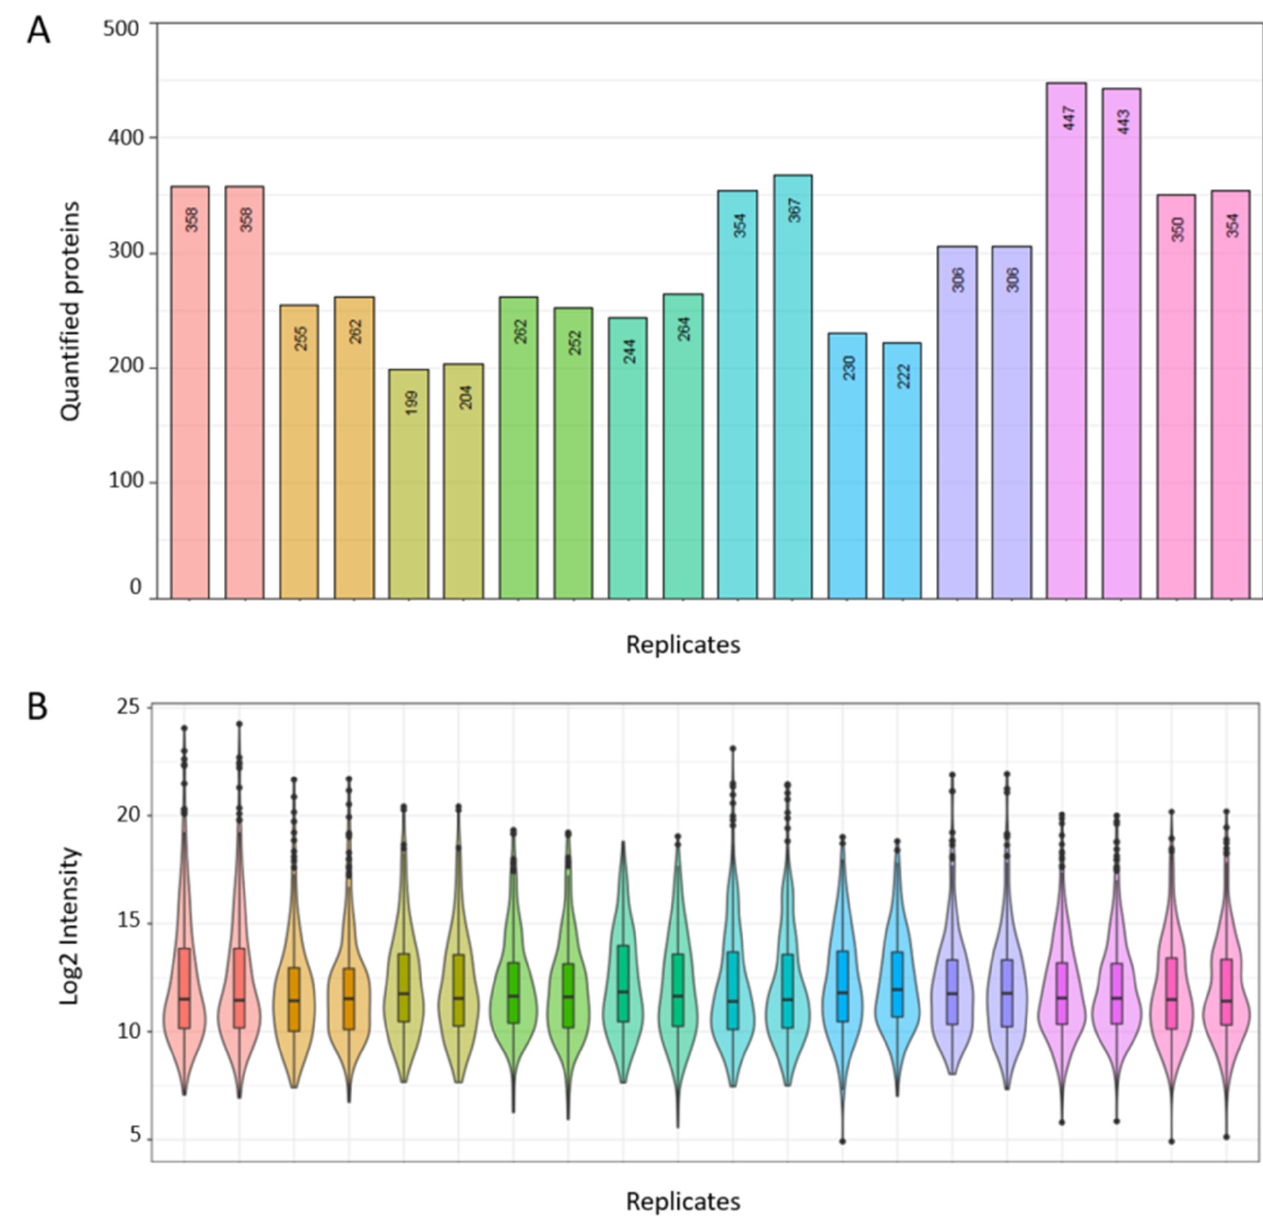
Figure 9. Real world application of spectral library for biomarker discovery based on cervico-vaginal fluid samples from five cancers and five controls. ( A ) Number of quantified proteins per study sample replicate. ( B ) Log 2 Intensity plot of corresponding sample replicates.